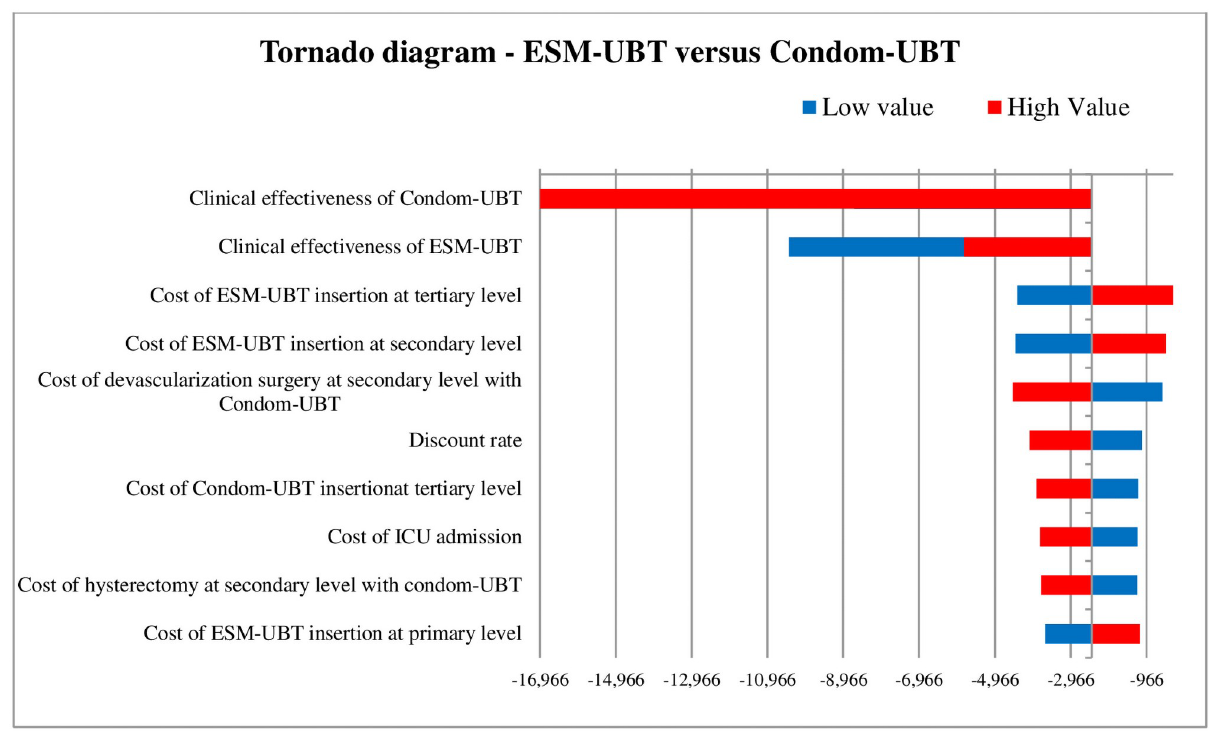
Fig 2. Tornado diagram showing one-way sensitivity analysis results for ESM-UBT versus condom-UBT comparison. As clinical effectiveness of condom-UBT increases, ESM-UBT is not cost-effective (ESM-UBT more expensive, less effective) as compared to condom-UBT. As clinical effectiveness of condom-UBT decreases (masked), ESM-UBT is cost-saving (ESM-UBT is less expensive, more effective) as compared to condom-UBT. Similarly, for ESM-UBT clinical effectiveness parameter, as clinical effectiveness of ESM-UBT increases, ESM-UBT is cost-saving (ESM-UBT less expensive, more effective) as compared to condom-UBT. As effectiveness of ESM-UBT decreases, ESM-UBT is not cost-effective (ESM-UBT more expensive, less effective) as compared to condom-UBT.